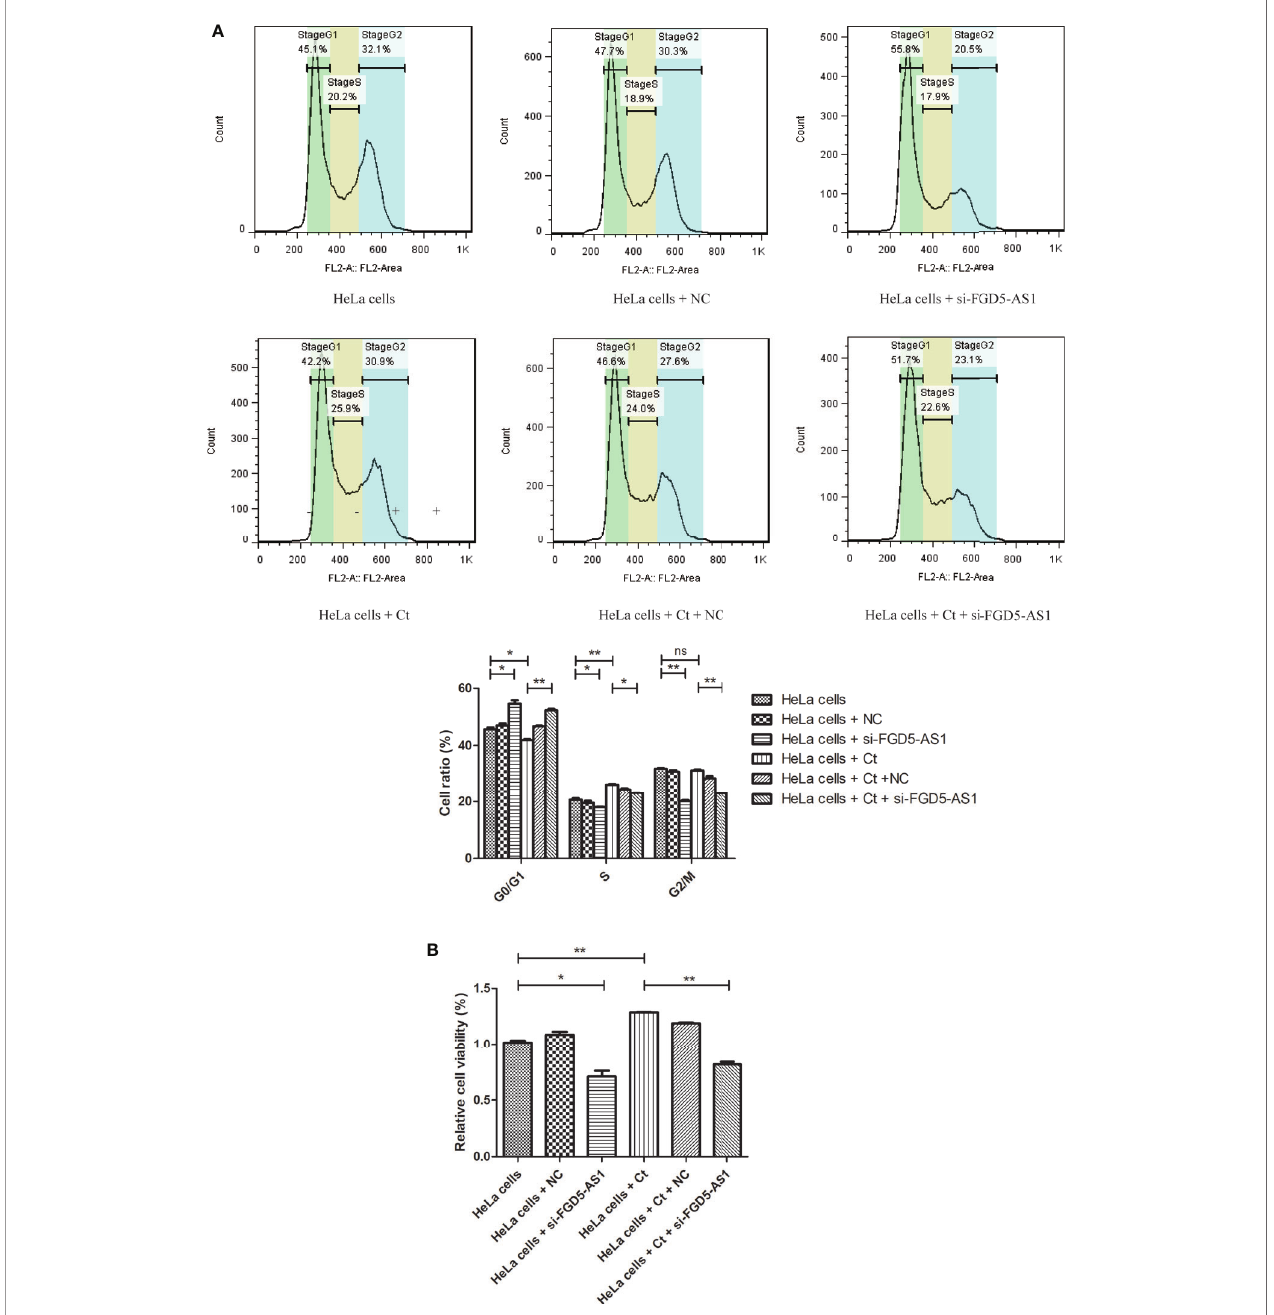
FIGURE 10 | Interference of lncRNA FGD5-AS1 promotes the DNA replication at 12 hpi. (A) FCM analysis was used to detect the DNA content of control cells and FGD5-AS1-interfered cells. The lower panel is the corresponding cell percentage. (B) MTT was used to detect the cell viability of infected cells. * P < 0.05; ** P < 0.01; NS, no signi fi